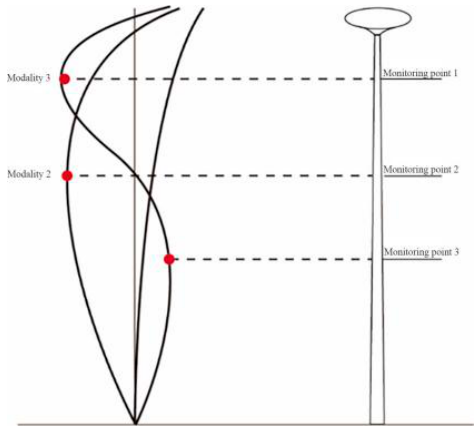
Figure 11. Location of measuring points.